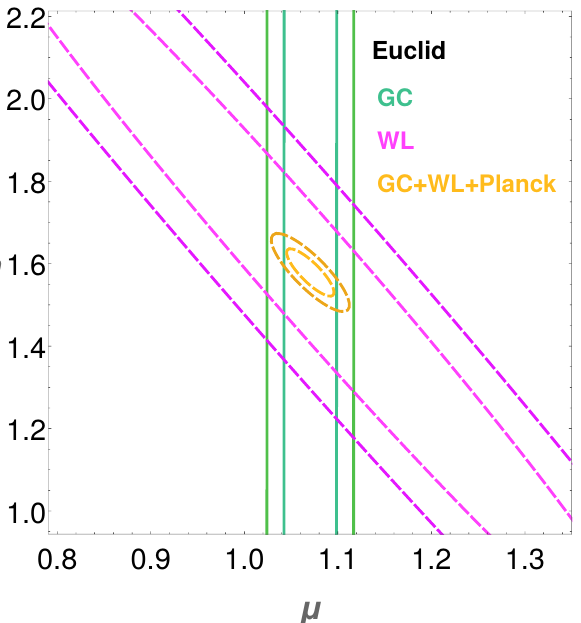
Figure 4. 68% and 95% confidence level contours on the current values of µ ( z ) and Σ ( z ) obtained using forecast observations for Euclid ’s spectroscopic GC (green) and photometric WL (purple). The combination of the two is studied with CMB data from Planck also included (orange). Reprinted from the work in [114], with permission from